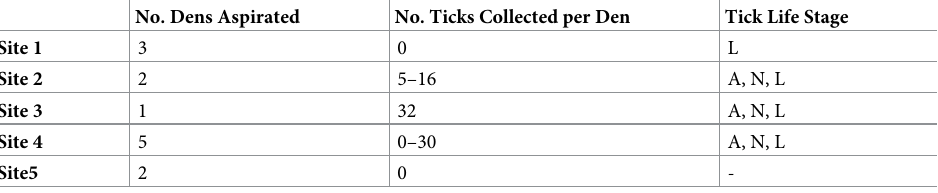
Table 2. Summary of tick